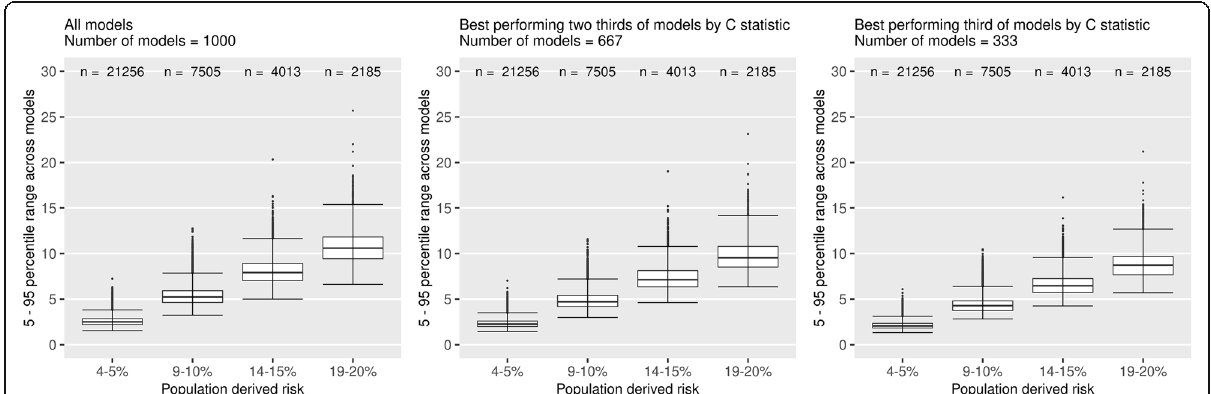
Fig. 3 Percentile ranges of risk for individuals, subsetted by C-statistic of the models (female cohort, N = 10,000). Each data point represents the 5 – 95th percentile range in risk for an individual across a group models defined by their C-statistic. Two thirds of models had C-statistic > 0.866%, and one third of models had C-statistic > 0.867%